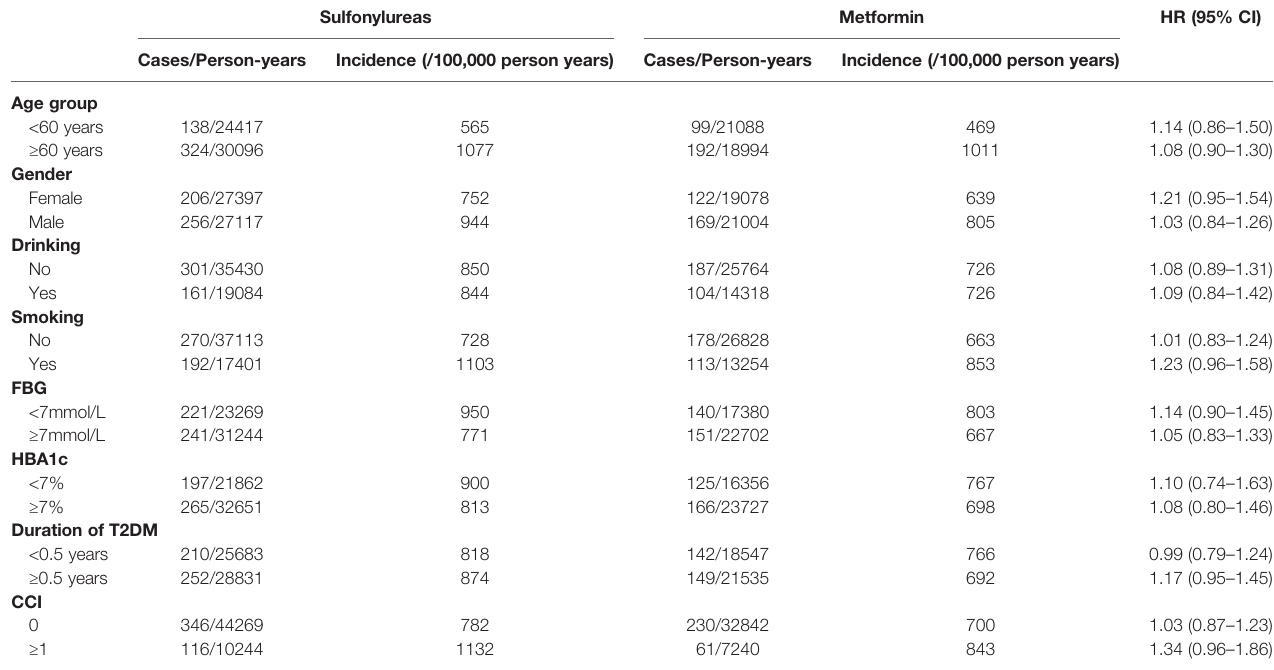
TABLE 3 | Association between the use of sulfonylurea and the risk of any cancer in various subgroups of